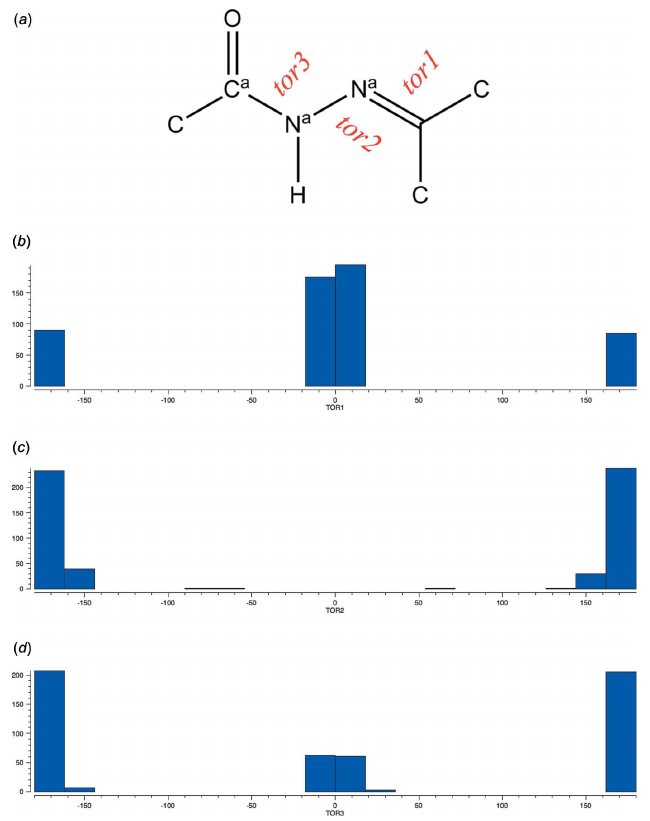
Figure 7 ( a ) The N -substituted hydrazide fragment used for a search in the CSD ( a refers to acyclic). ( b )–( d ) Histograms of torsion angles tor1 , tor2 and tor3 , respectively.